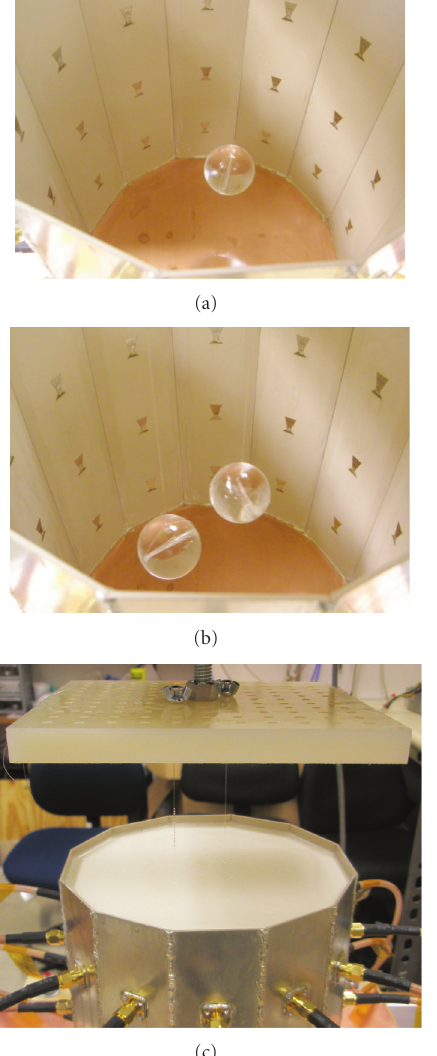
Figure 19: Test objects and coupling fluid for Experiment 1. (a) Single suspended acrylic sphere. (b) Two acrylic spheres. (c) Cavity filled with the coupling medium. Objects are suspended and rotated from the nylon platform.